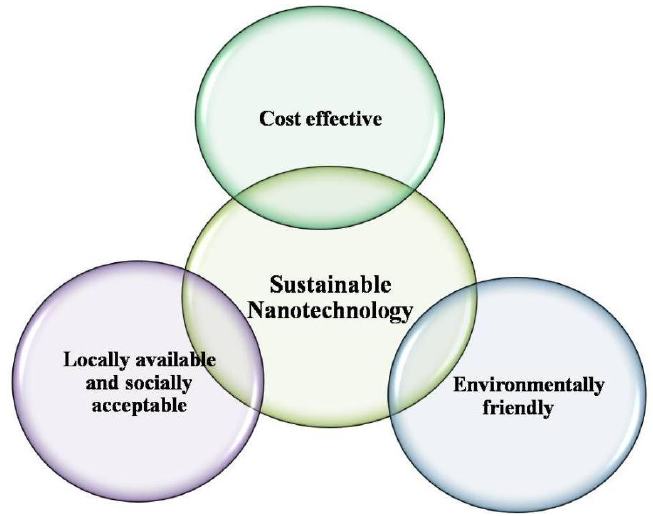
Figure 1. Sustainable green nanotechnology.